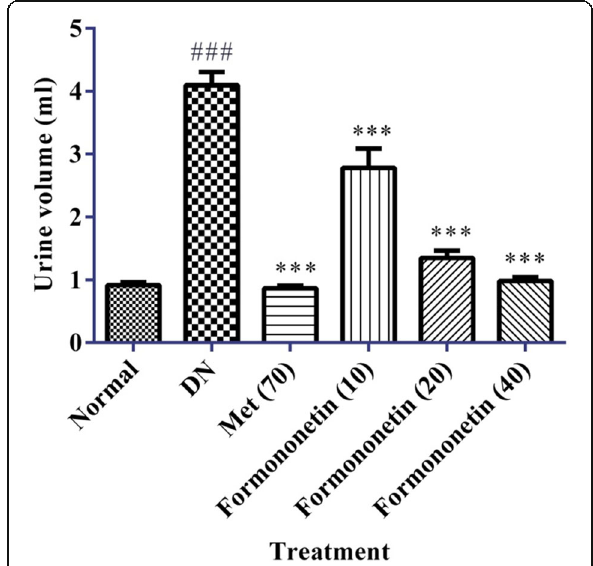
Fig. 2 Effect of formononetin on urine volume. Data were presented as mean ± S.E.M. (n-6). The result values were statistically analyzed by using one-way ANOVA followed by Bonferroni ’ s test for multiple